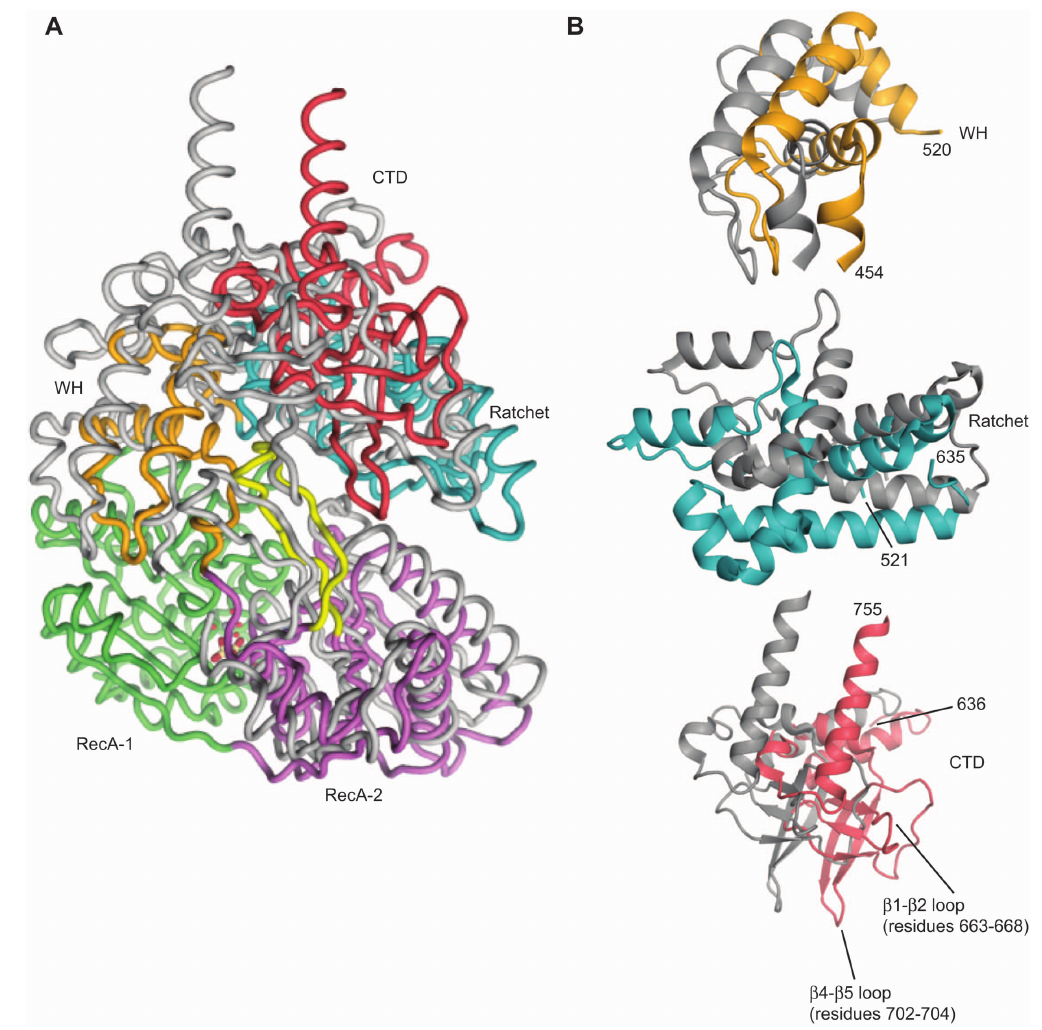
Figure 5 The conformational changes from the crystallized ADP state to the modeled nucleic acid-bound state. (A) Overview of domain movements between the ADP state (color) and the modeled nucleic acid-bound state (gray). The position of the RecA-1 is kept constant. The NTD is not shown. (B) Movements of the WH (top), Ratchet (middle) and CTD domains (bottom) between the ADP state (color) and the modeled nucleic acid-bound state (gray). The first and last residues in the domains are labeled. 4A and 5B). These modeled domain rearrangements